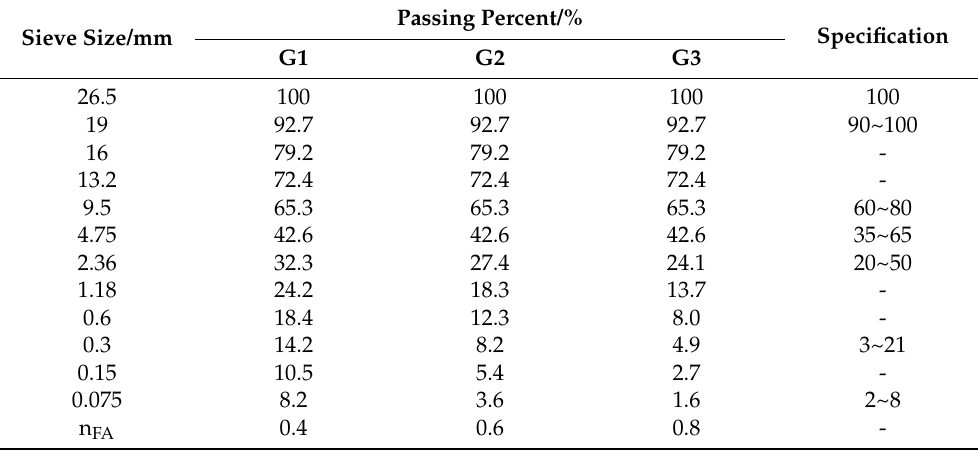
Table 5. Gradations of the three types of CRME.